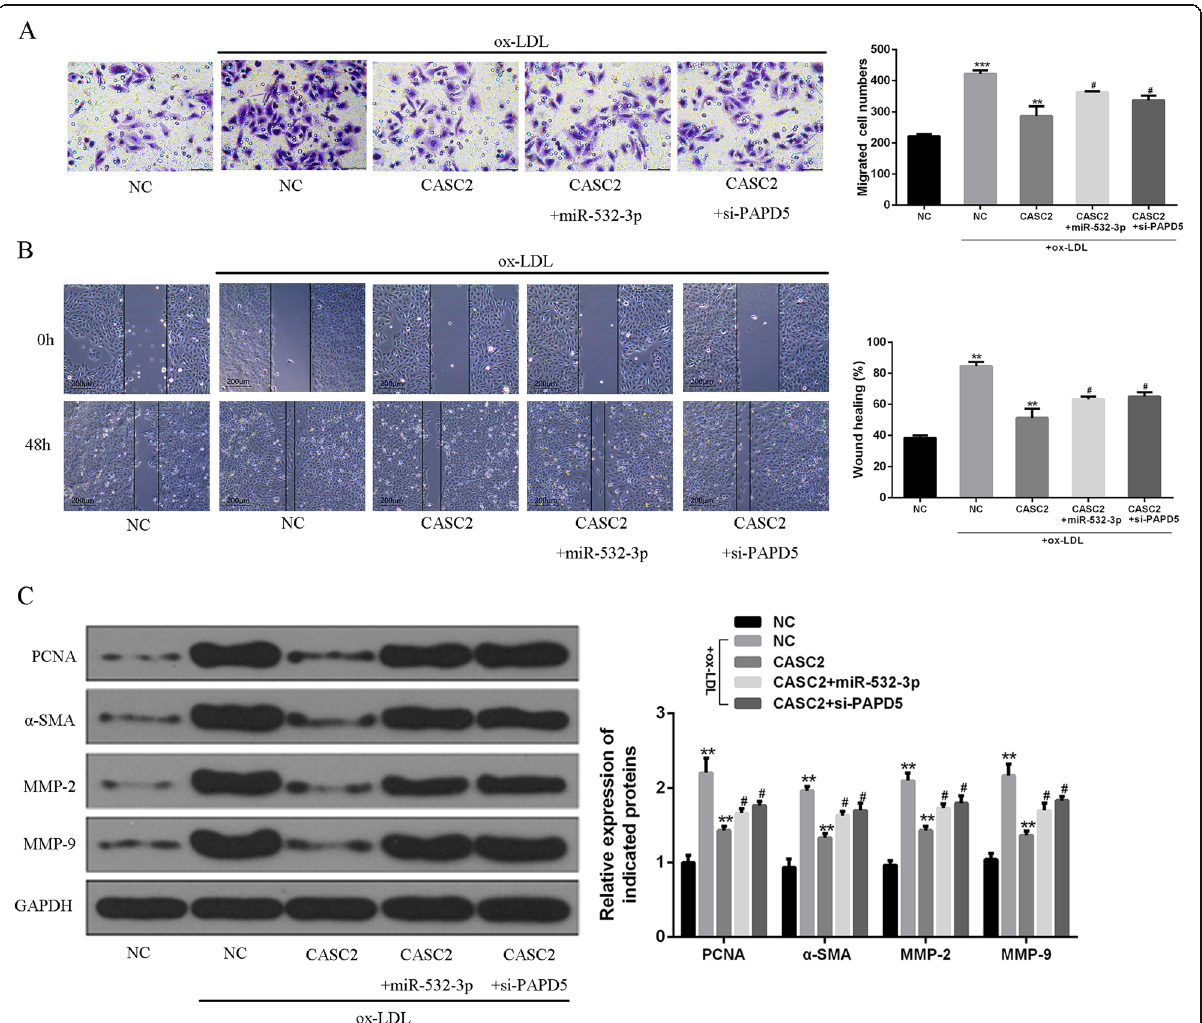
Fig. 5 Effects of over-expression of miR-532-3p or silencing of PAPD5 on CASC2-induced migration of VSMCs. a Transwell assay of VSMCs co- transfected with CASC2 or control, and miR-532-3p mimic or si-PAPD5. b Wound healing assay of VSMCs co-transfected with CASC2 or control, and miR-532-3p mimics or si-PAPD5. c Western blotting for proliferation and migration related proteins expression in VSMCs co-transfected with CASC2 or control, and miR-532-3p mimic or si-PAPD5. * vs. NC group or NC + ox-LDL group, # vs. lncCASC2 group. ***P < 0.001, ** P < 0.01, # P <